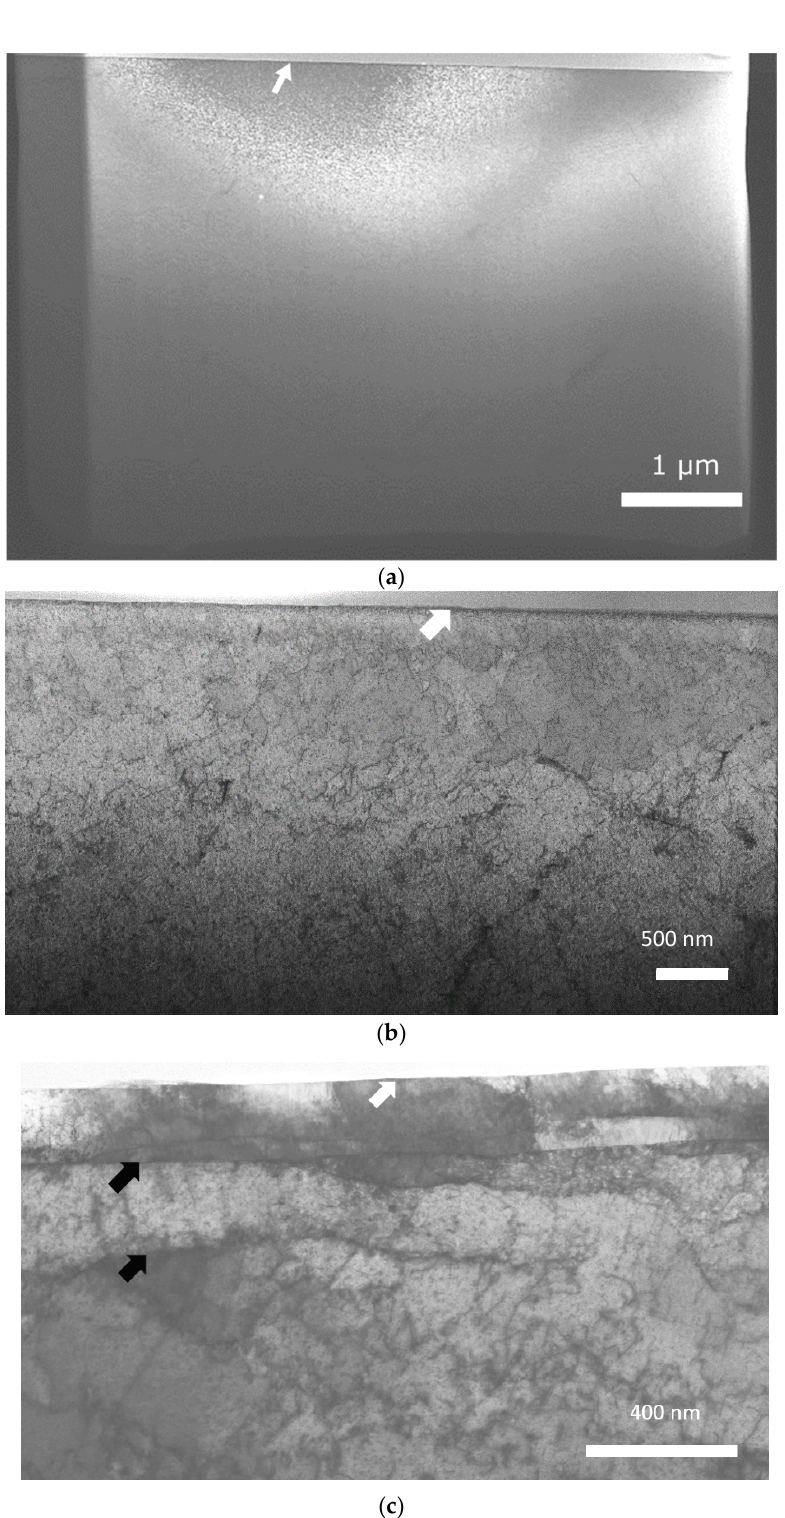
Figure 5. T-SEM images (30 kV, 0.1 nA) of foils prepared from the unworn sample ( a ) and at sliding distances of ( b ) 1.8 mm with 28 mN normal load and ( c ) 1.967 mm with 250 mN normal load in the wear track of experiment 1. The white arrows indicate the sample surfaces, while the black arrows mark the DTLs at depths of 190 and 440 nm. The positions of the foils within the wear track are indicated by the black rectangles in Figure 4, where foil b is prepared from the position in rectangle 1 and foil c from the position in rectangle 2. All foils in the wear track were prepared parallel to the sliding